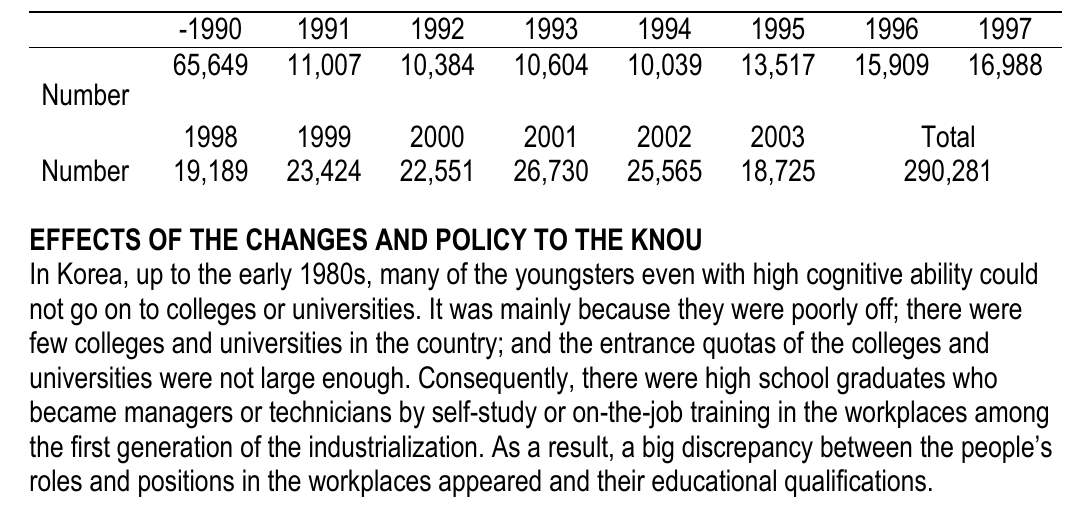
Table 11. Number of graduates from the